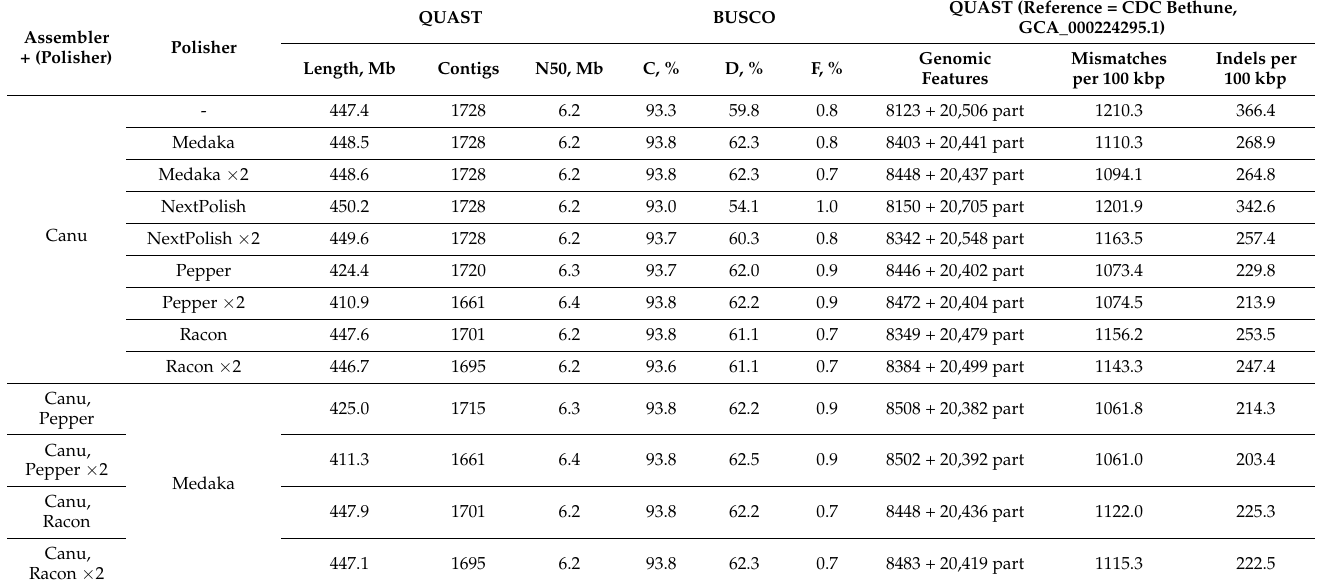
Table 2. QUAST and BUSCO statistics for the polished genome assemblies of L. usitatissimum line 3896 (computed relative to the CDC Bethune assembly and